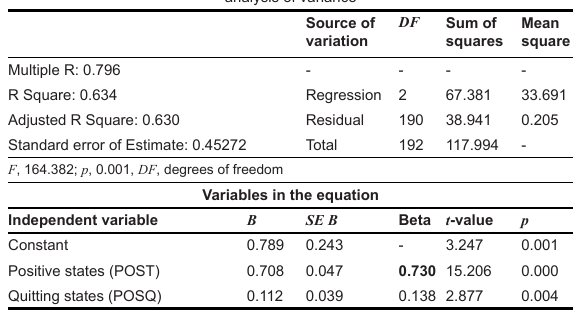
TABLE 8 analysis of variance DF Sum of Source of Mean variation squares square